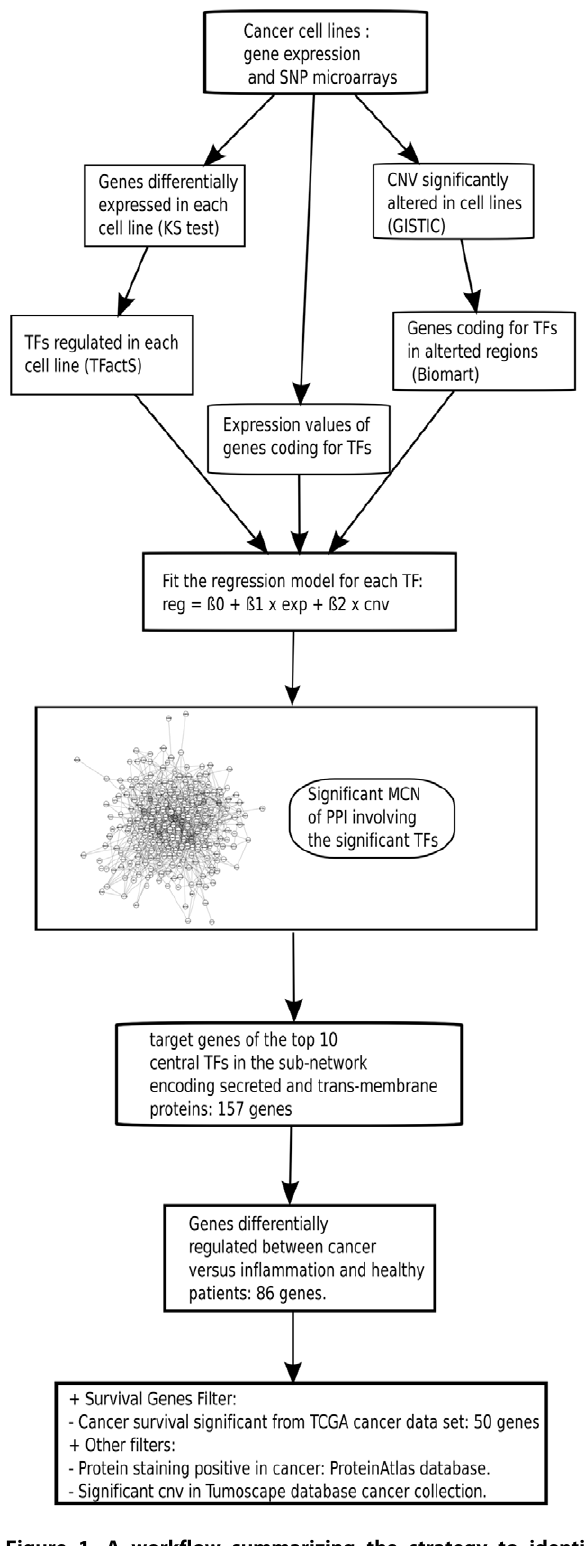
Figure 1. A workflow summarizing the strategy to identify accessible common cancer biomarkers. See text for details. Reg: regulation; Exp: expression; CNV: copy number variation; MCN: minimal connected network; PPI: protein-protein interactions; TF: Transcription factor.